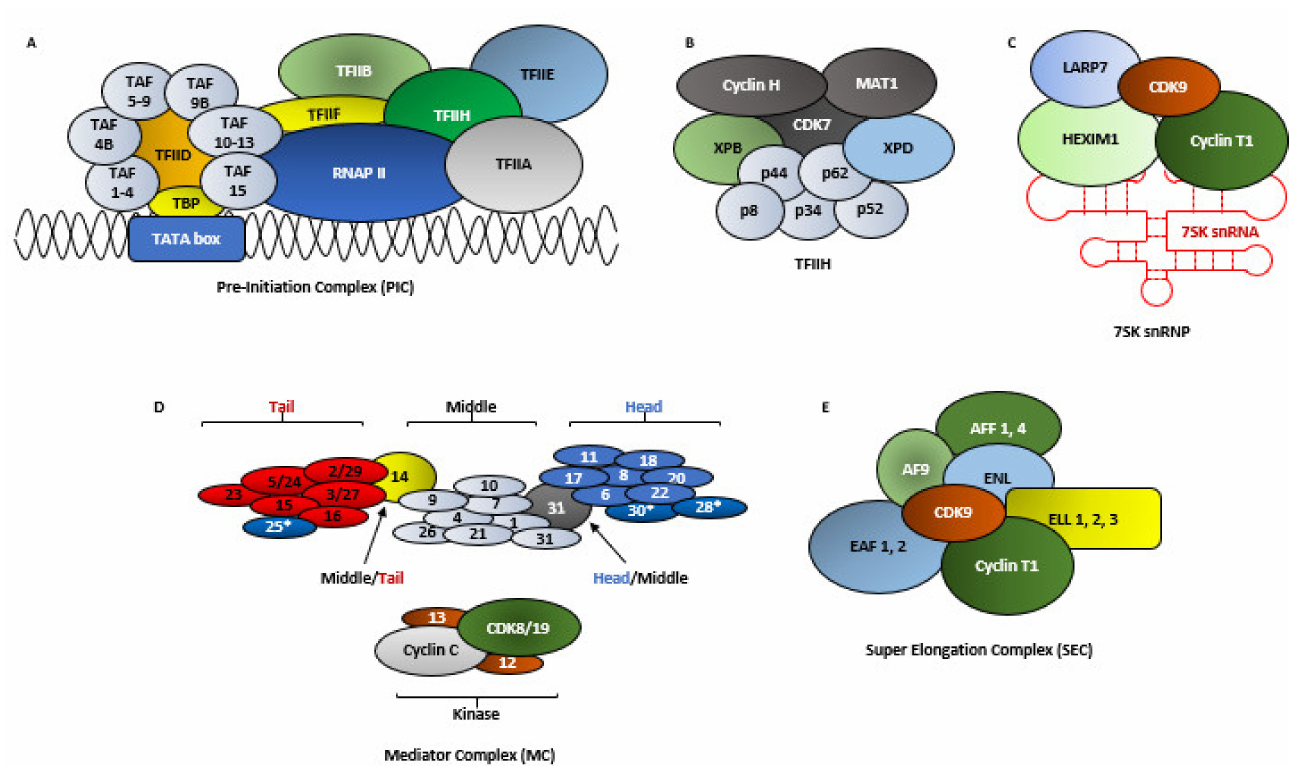
Figure 3. The structures of key complexes involved in RNAP II mediated transcription and regulation of CDK9 activity. ( A ) Pre-Initiation Complex (PIC)–the PIC is composed of RNAP II which is assisted by General Transcription Factors (GTFs) like TFIIA, TFIIB, TFIID, TFIIE, TFIIF and TFIIH. TFIID in-turn is composed of the TATA box-Binding Protein (TBP) and upto 15 TBP Associated Factors (TAF). TFIID, assisted by TFIIA, first recognizes the core promoter by scanning